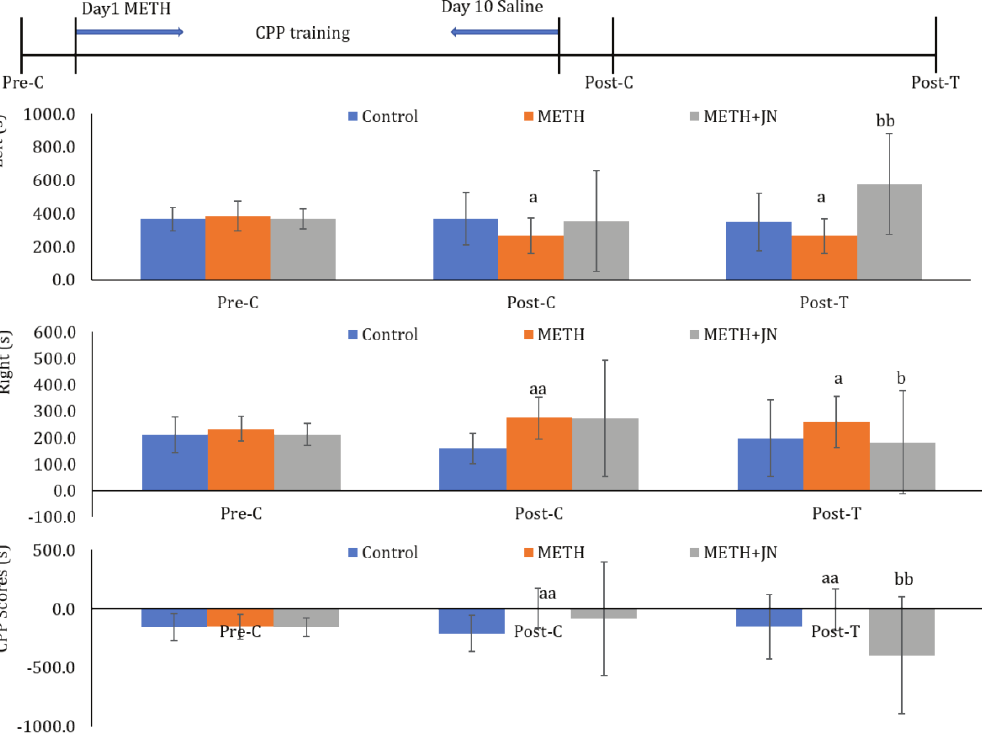
Figure 3: Effects of repeat doses of Jinniu Capsule on METH withdrawal in the CPP test. Means ± SD, n = 10, a P < 0.05 vs control group; aa P < 0.01 vs control group; b P < 0.05 vs METH group; bb P < 0.01 vs METH group. Pre-C: preconditioning test; Post-C: postconditioning test; Post-T: post treatment test. The doses of METH and Jinniu Capsule were 3 mg/kg and 0.8 g/kg respectively. The Pre-C, Post-C and Post-T tests were performed; Jinniu Capsule was administered every day for totally 7 days after the CPP training.